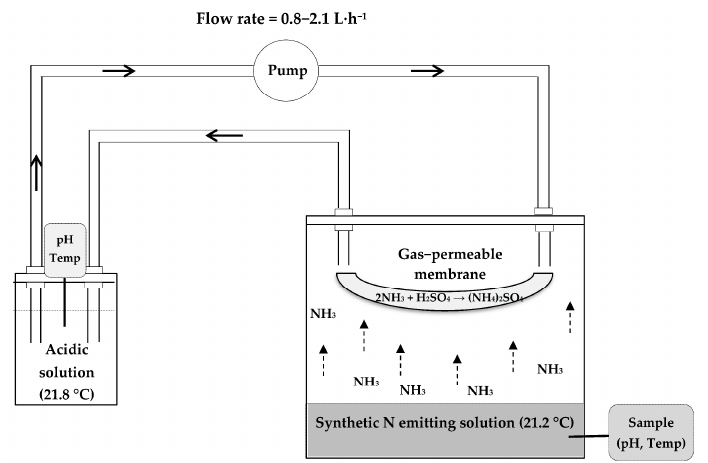
Figure 1. Diagram of the NH 3 capture process by the suspended gas permeable membrane system in a closed circuit.